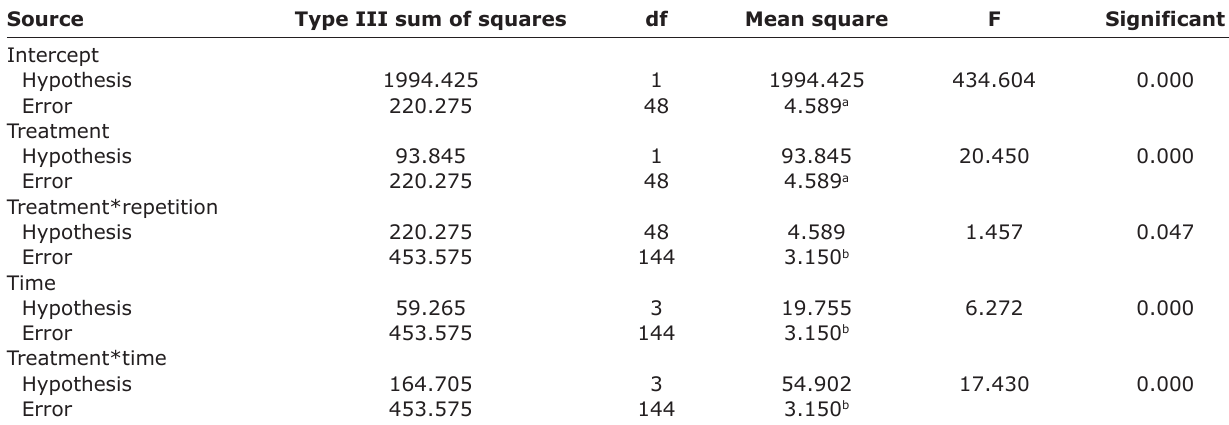
Table-2: Effects of the vaccination on antibody against EDS in the commercial laying chickens. Source